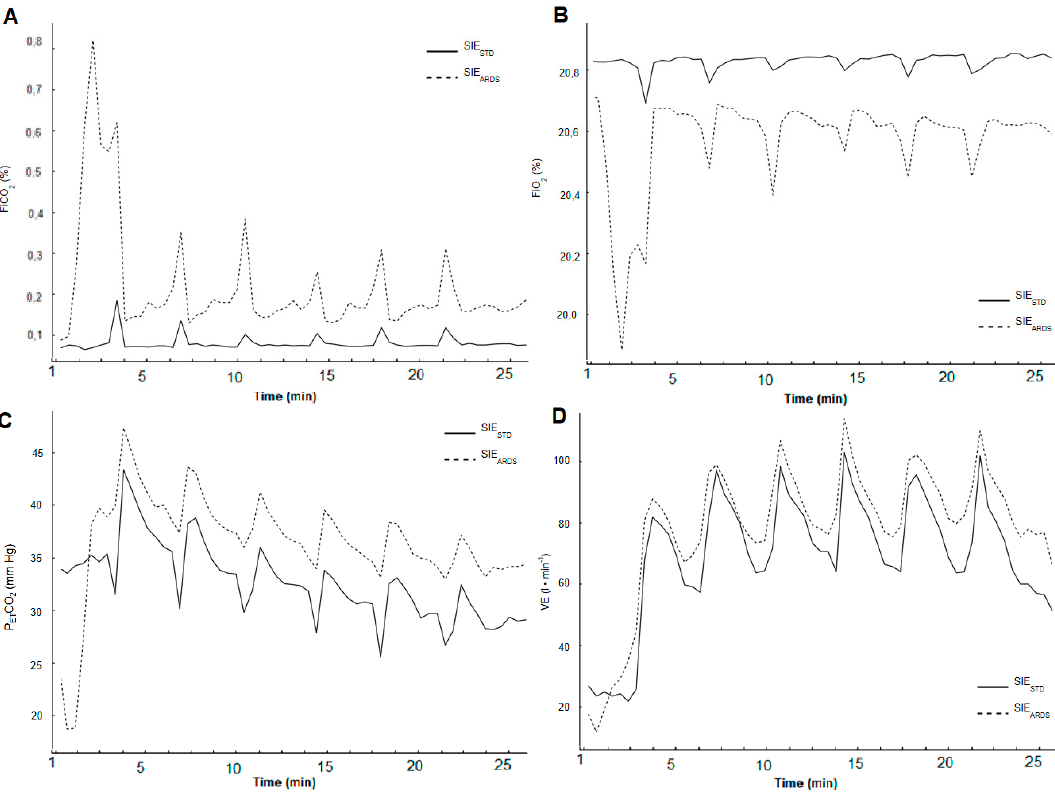
Figure 5. The average values of ( A ) FiO 2 , ( B ) FiCO 2 , ( C ) P ET CO 2 , and ( D ) ventilation (VE)—two minutes before, during and four minutes after last bout in SIE STD and SIE ARDS (27 min total). Table 2. Comparison of mean (x ̄ ± SD) physiological responses between both SIE protocols.